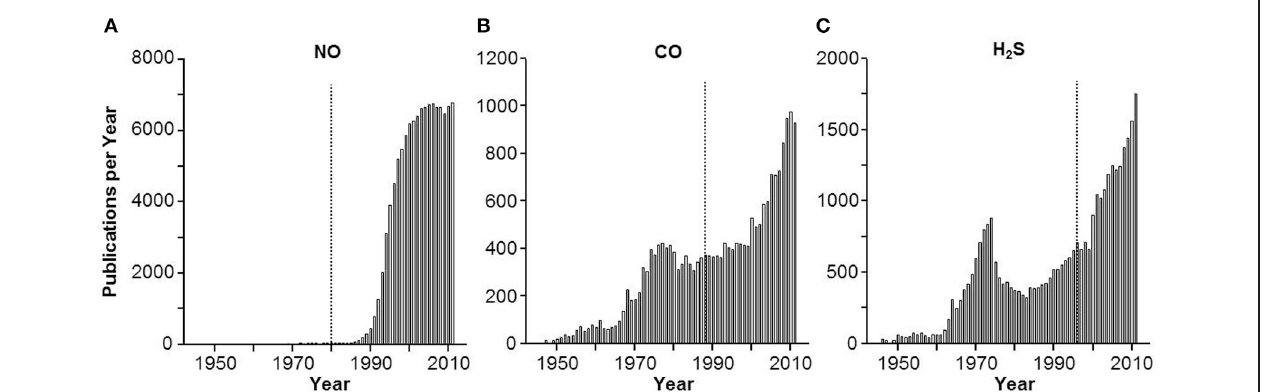
FIGURE 1 | Frequency histogram of the number of yearly publications on (A) nitric oxide (NO), (B) carbon monoxide (CO) and (C) hydrogen sulfide H 2 S. Vertical lines indicate approximate year of the first description of a